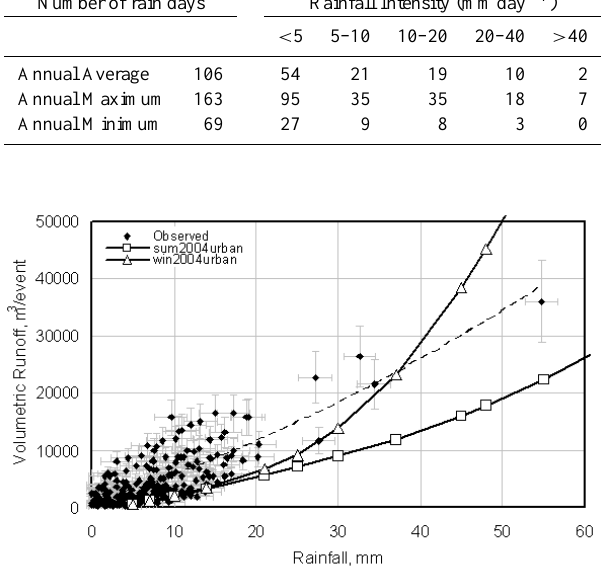
Fig. 7. Urban volumetric runoff (in legend: D – storage deficiency Figure 7. Urban volumetric runoff (in legend: D - storage deficiency stage; R - storage stage; R – storage recovery recovery stage)